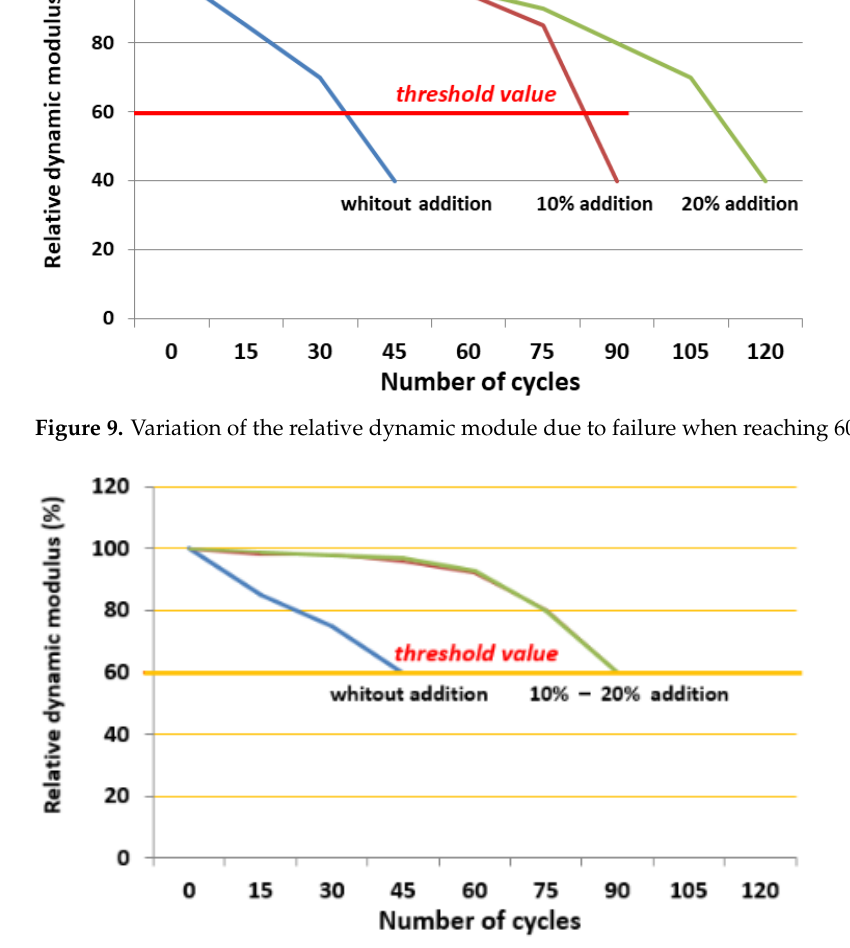
Figure 10. Variation of the relative dynamic modulus due to cracking failure.